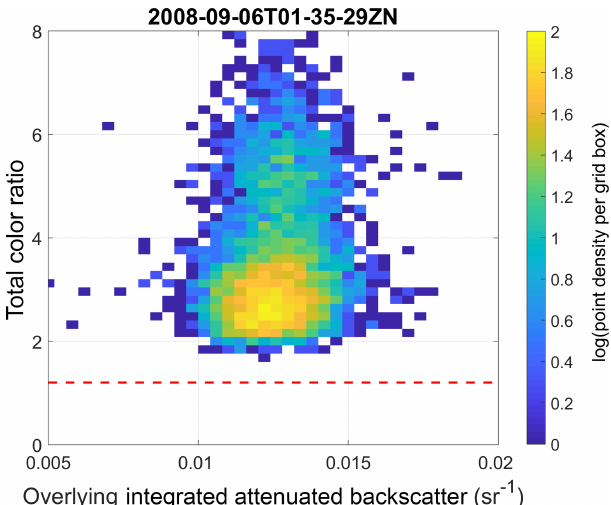
Figure 9. Joint distribution of integrated attenuated backscatter color ratio χ (cid:48) of the water clouds and overlying 532nm integrated attenuated backscatter γ (cid:48) above the water clouds for the 6 Septem- ber 2008 data segment shown in Fig. 8. The dashed line corresponds to the value expected in the absence of overlying smoke